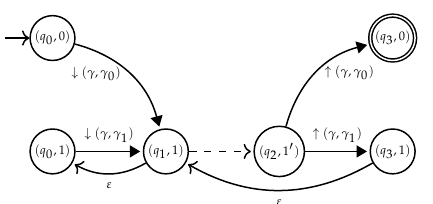
Figure 10. The multi-module NWA for